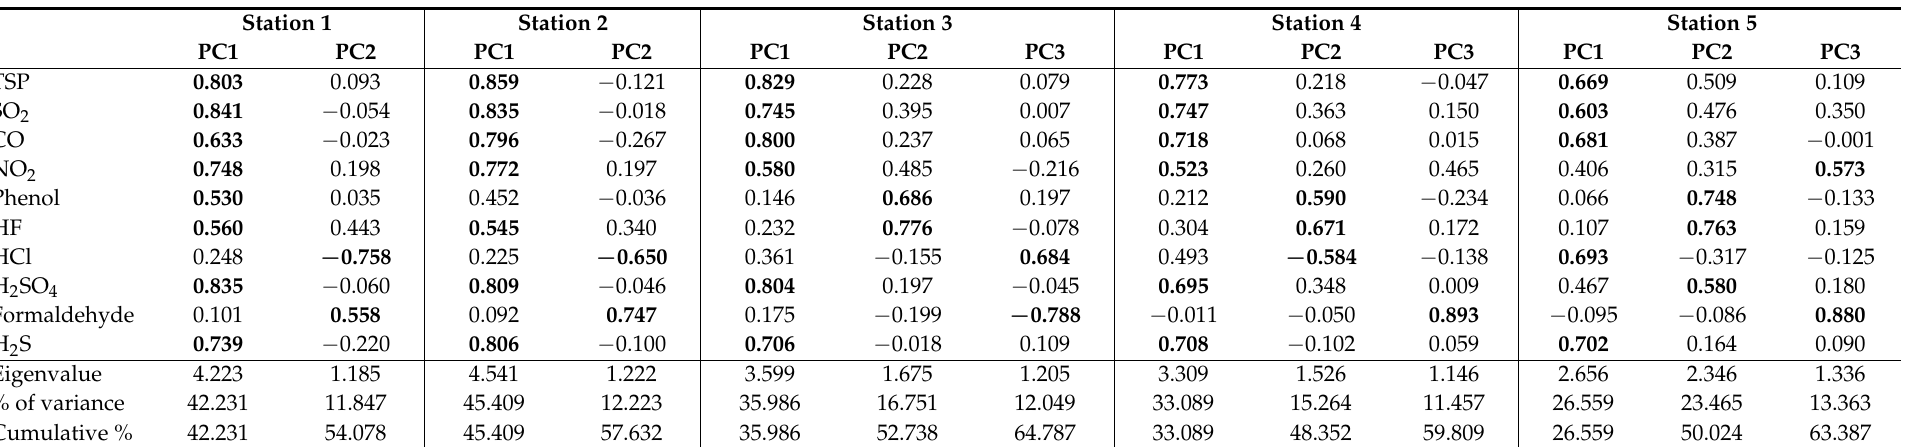
Table 4. Principal Component Analysis for the cold seasons.